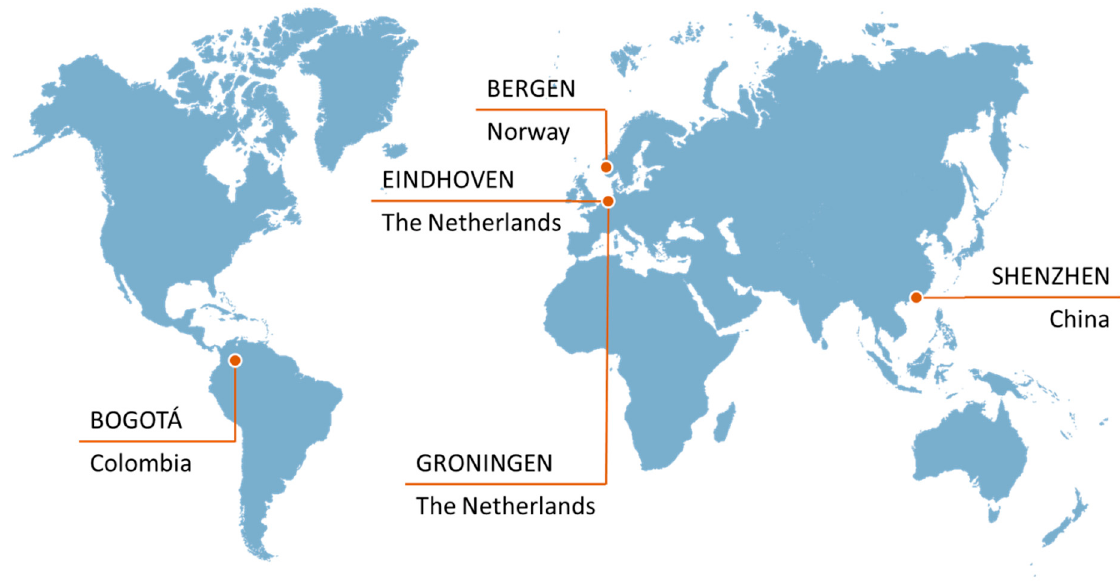
Figure 2. Location of the cities selected for the identification of warehouse electrification experi ‐ ences.